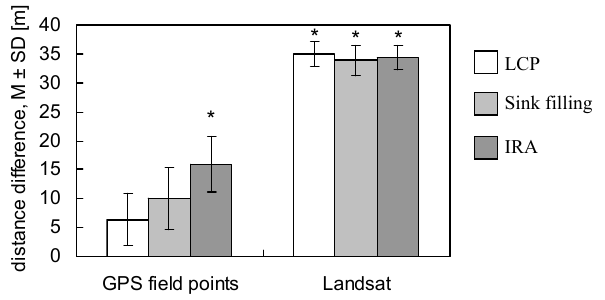
Fig. 7. Mean and standard deviation of the distance differences between the 30m SRTM DEM and the 30m IFSARE DEM. A pos- itive distance difference indicates that streams extracted from the 30m IFSARE DEM are closer to reference points than streams ex- tracted from the 30m SRTM DEM. LCP: least-cost path search; IRA: impact reduction approach.